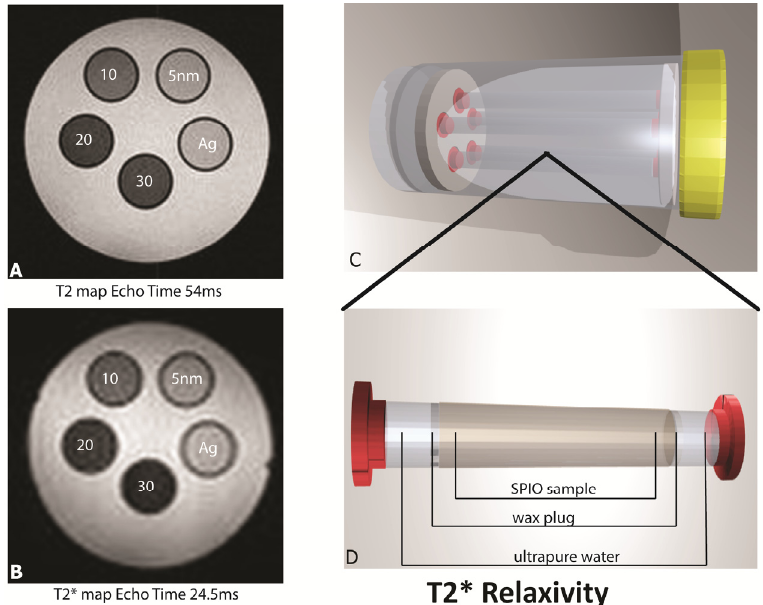
and r * values for 5, 10, 20, and 30 nm core size SPIONs with 95% ( E ) Comparison of r 2 2 CI displayed as error bars; ( F ) Plot of the relaxation rate vs. concentration of iron expressed in units of mM free iron. The slope of the relaxation rate vs. concentration curve